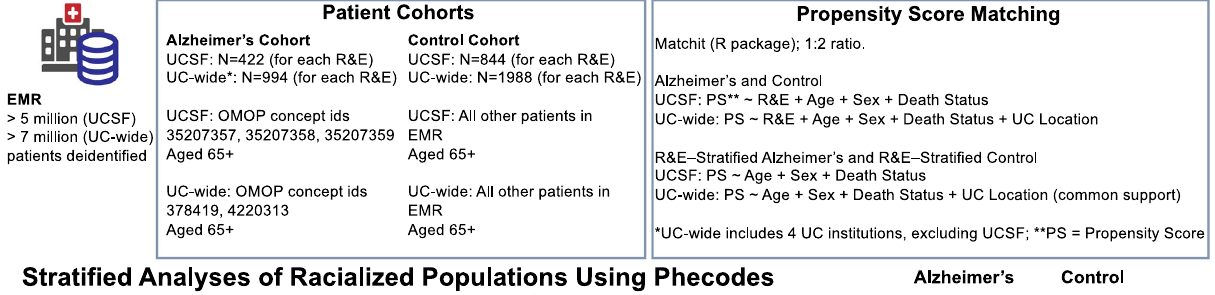
Table 1 Overview of patient